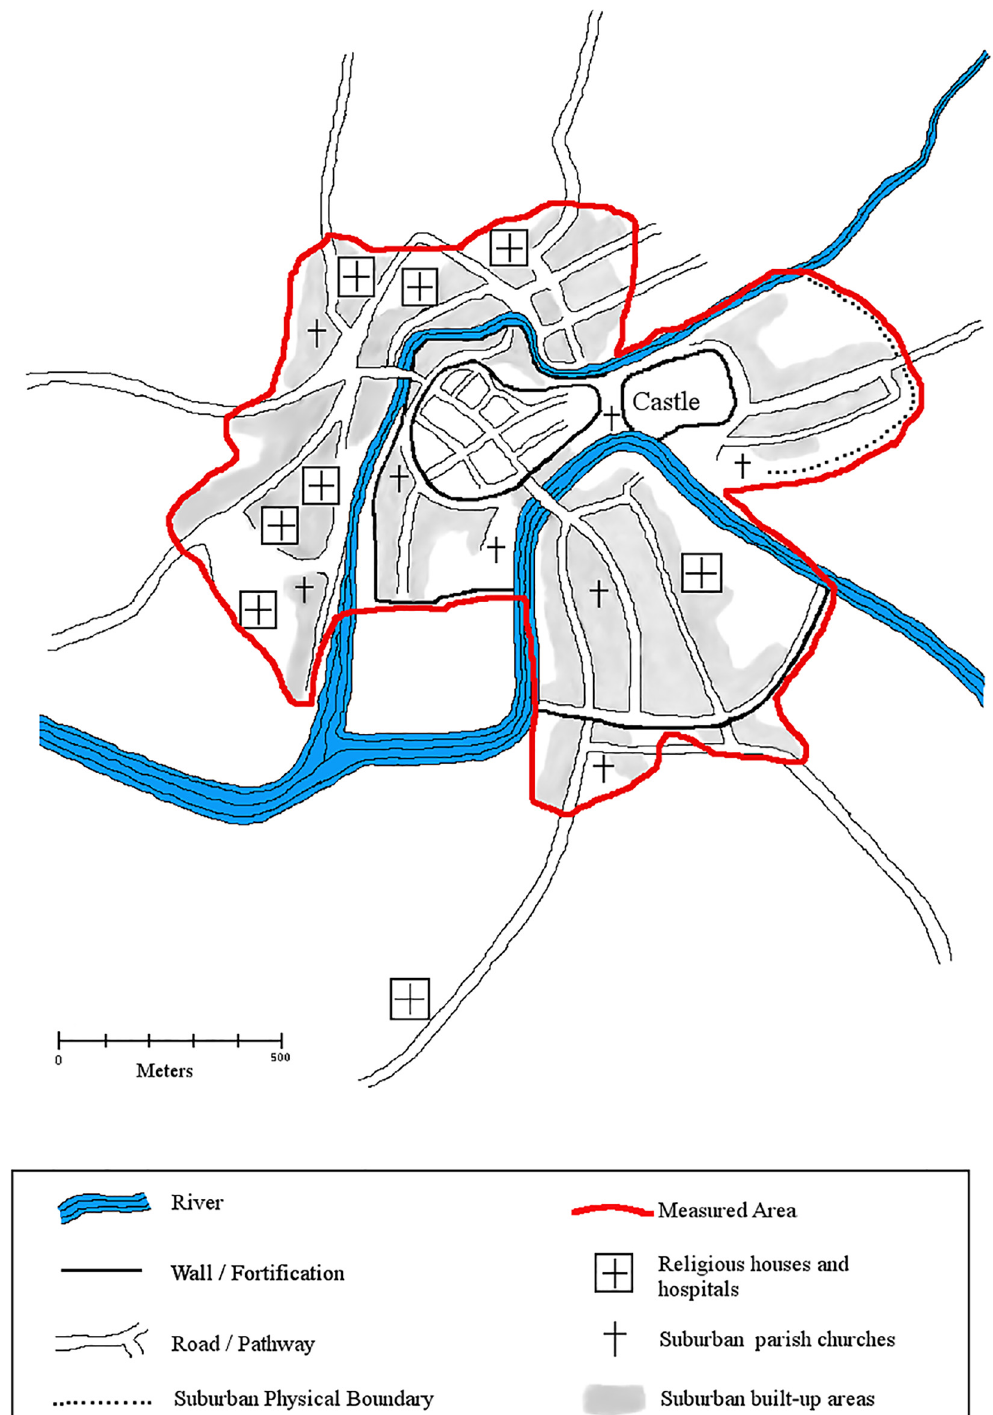
Fig 5. Measuring the Settled Area of Medieval Settlements. Bristol ’ s built-up areas in the later middle ages (late 13th – early 14th centuries), including built-up suburban areas shaded in grey. The red line indicates the 130 ha settled area we measured for the city, whereas the inner area circumscribed by walls and rivers measures only 55 ha. Even our relatively conservative outline of the city ’ s built up area more than doubles Bristol ’ s settled area. This map is modified and redrawn by the authors from Derek Keene ’ s (1976) map of the suburban built up area of later medieval Bristol